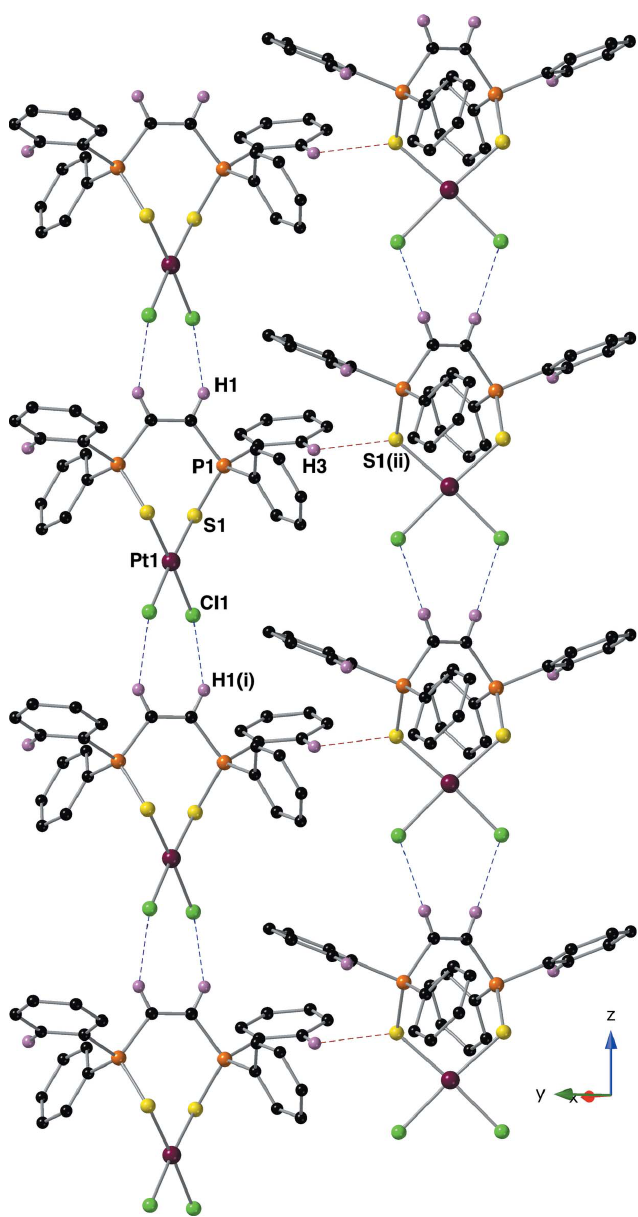
Figure 6 This figure shows the intermolecular C—H (cid:2)(cid:2)(cid:2) Cl and C—H (cid:2)(cid:2)(cid:2) S hydrogen bonds present in the crystal of compound II using a ball-and-stick model with standard CPK colors (Pt = maroon). Hydrogen bonds are drawn with blue (C—H (cid:2)(cid:2)(cid:2) Cl) or red (C—H (cid:2)(cid:2)(cid:2) S) dashed lines, and only hydrogen atoms H1 and H3 are shown for clarity. Symmetry codes: